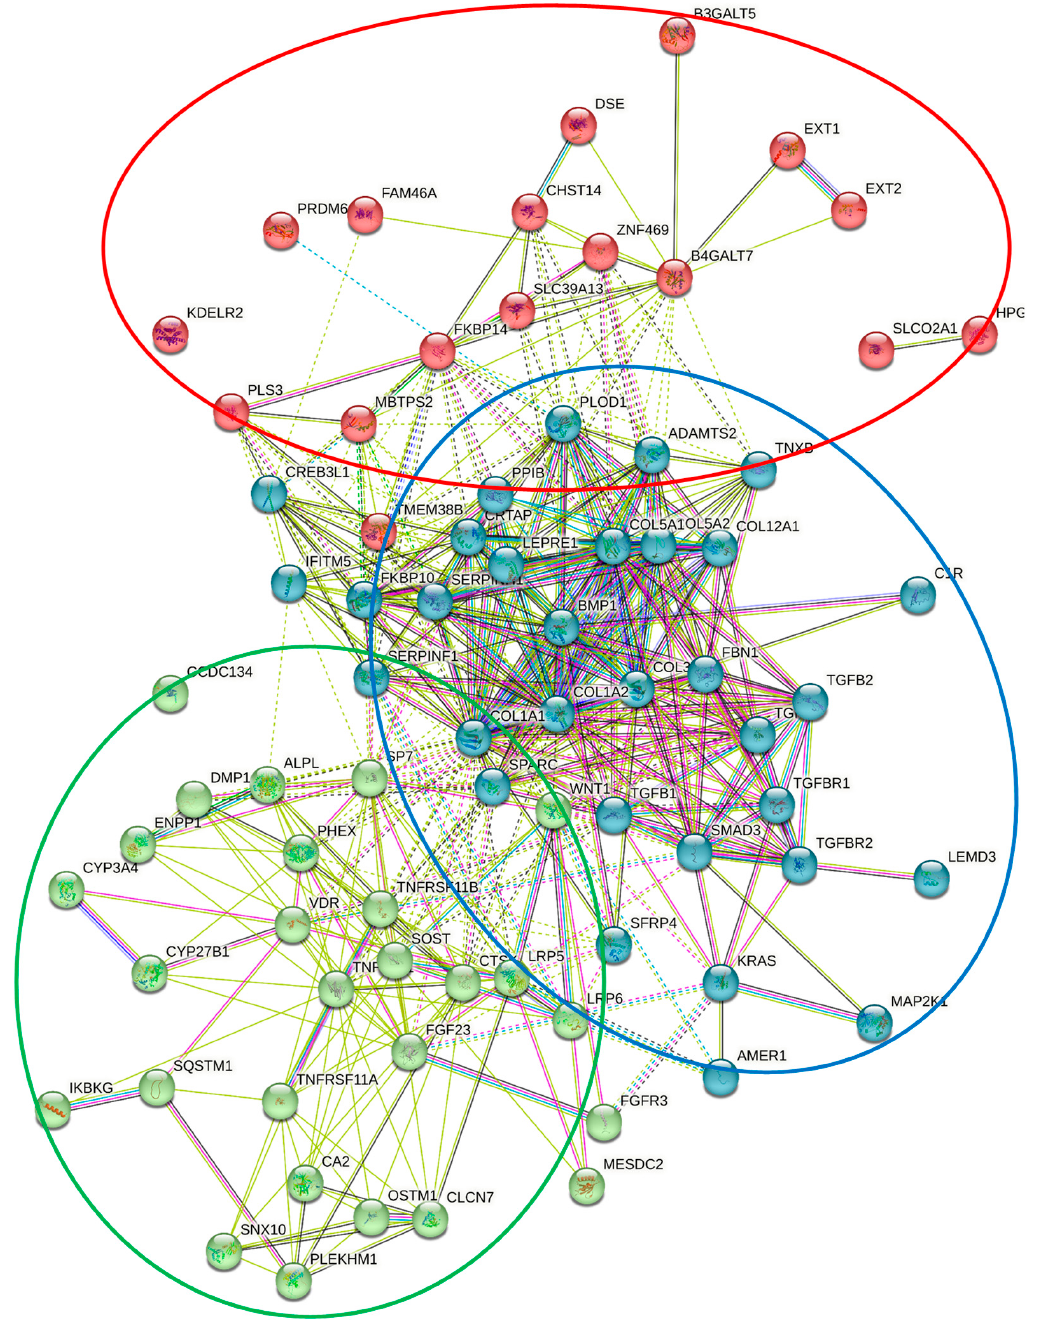
Figure 2. Protein–protein Interaction (PPI) Network was constructed from 78 genes contributing to hereditary metabolic bone